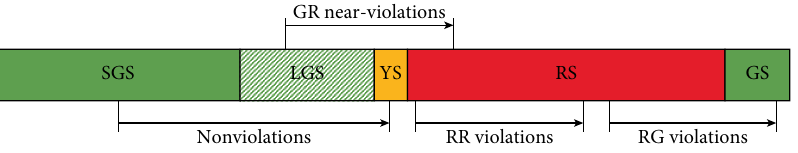
Figure 3: Signal phases and violation types.